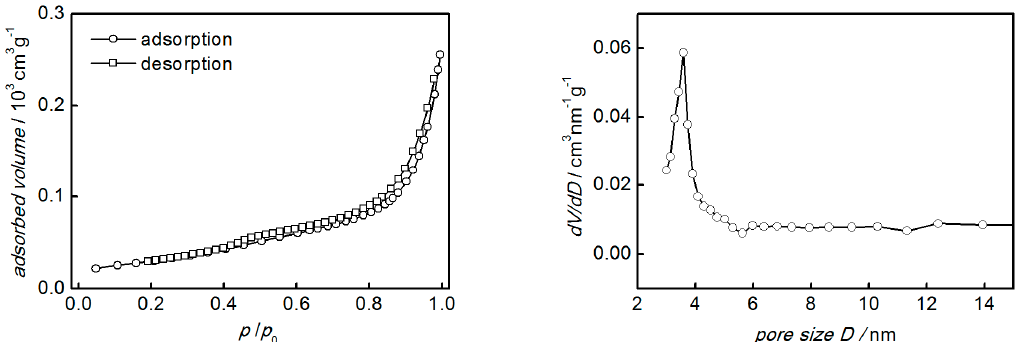
Figure 6. N 2 physisorption isotherm ( left ) and pore size distribution ( right ) of MgO prepared using PDMAAm polymer as the porogenic structure matrix.